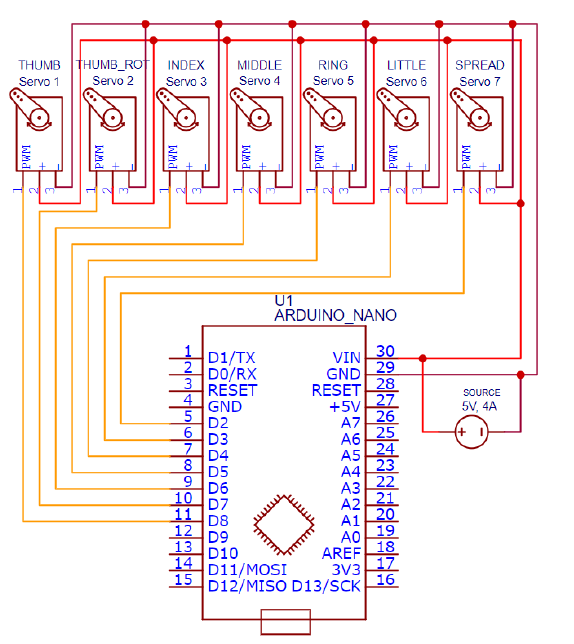
Figure 6. PCB Design. Figure 7. Wiring